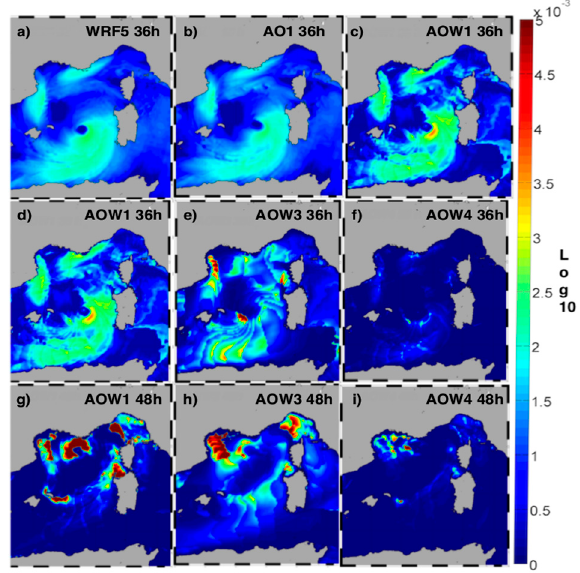
Figure 10. Surface roughness values (log10) in different runs. Panels ( a – c ): values for runs WRF5, AO1 (using Charnock 1955 scheme) and AOW1 (using the OOST scheme), on 7 November 2011, 12:00 UTC (36 hours after the start of simulation). Panels ( d – f ): values for runs AOW1 (OOST scheme), AOW3 (TYscheme) and AOW4 (DRE scheme), on 7 November 2011, 12:00 UTC. Panels ( g – i ): values for runs AOW1, AOW3 and AOW4, on 9 November 2011, 00:00 UTC.